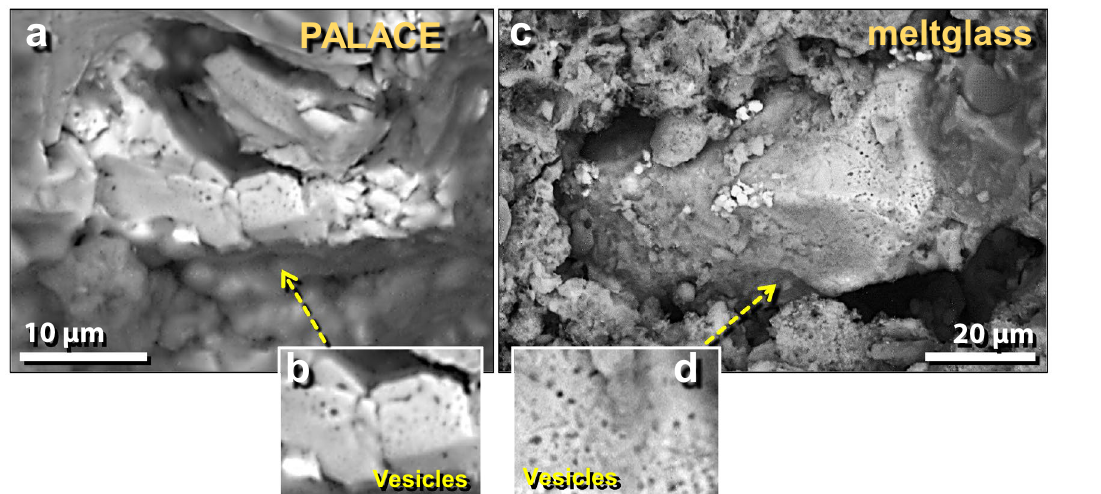
Figure 39. SEM images of melted iron and titanomagnetite in mudbrick meltglass from the palace. ( a ) Shattered elemental Fe grain containing < 0.1 wt.% oxygen as determined by SEM–EDS; ( b ) close-up showing surface porosity. ( c ) Titanomagnetite grain showing surface porosity; ( d ) close-up showing aligned porosity possibly along former grain boundaries. The cause of the porosity is uncertain, but because these grains are associated with other high-temperature melted minerals, we propose that this porosity resulted from exposure to high